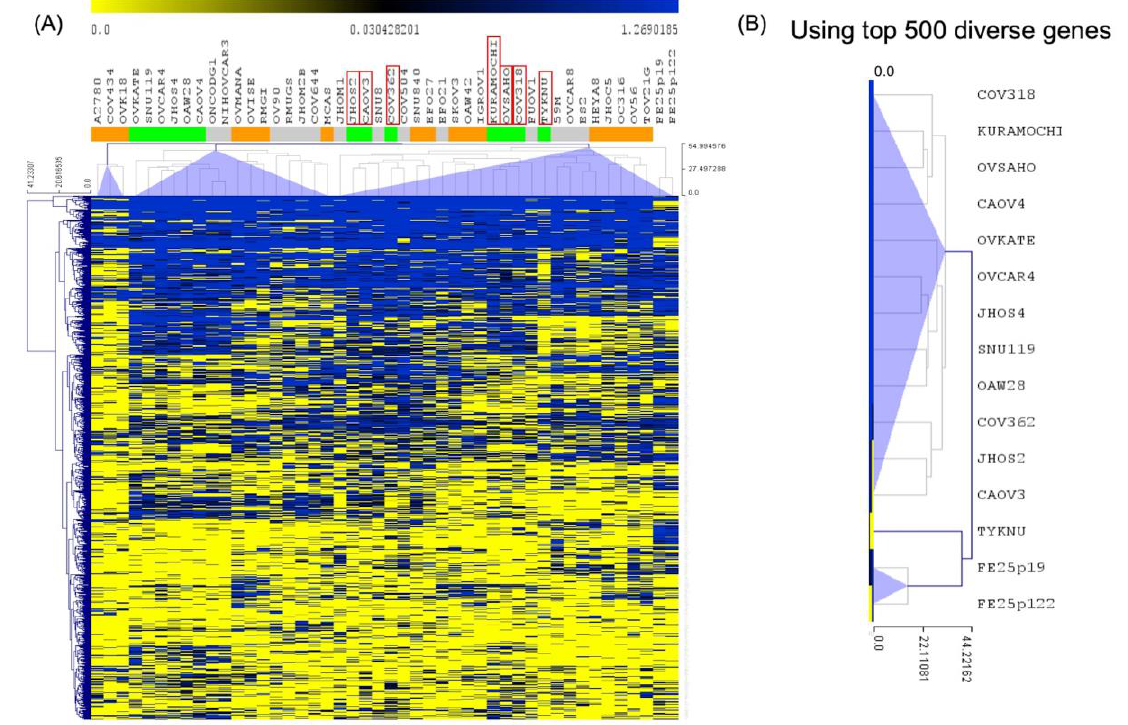
Figure 10. Unsupervised hierarchical clustering analysis of RNA expression. ( A ) Clustered image map of FE25 (p19) and FE25L (p122) by analyzing mRNA expression levels. ( B ) The most correlated group 1 HGSOC lines were JHOS2, CAOV3, COV362, and TYKNU using the top 500 diverse genes of group 1 HGSOC (likely HGSOC) cell